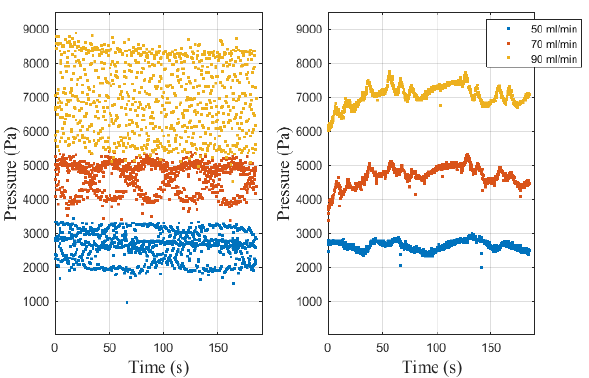
Figure 6. Measured pressure in the pipe. The left side is the measurement of the air pressure sensor, and the right side is the measurement of the touch sensor.